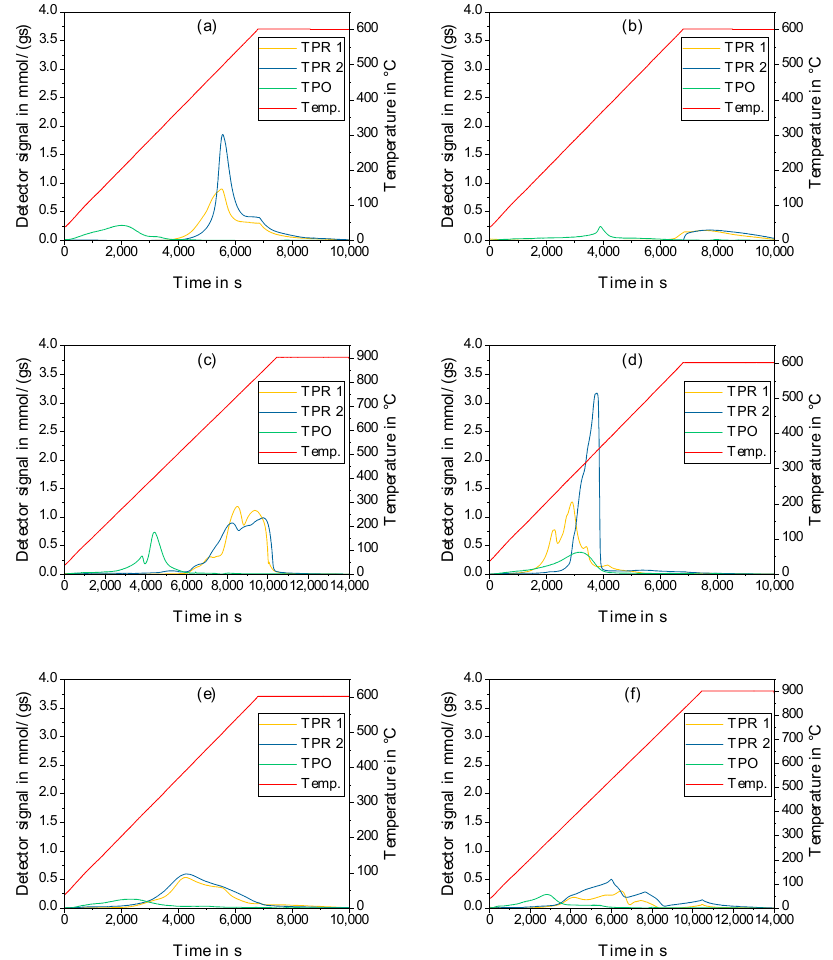
Figure 6. Results of TPROR measurements up to 600 ◦ C ( a , b , d , e ) and 900 ◦ C ( c , f ): ( a ) Molybdenum- silica system with a signal maximum of the second TPR at about 500 ◦ C. ( b ) Tungsten-silica system without significant signals for reduction up to 600 ◦ C. ( c ) Tungsten-silica system with two signal maxima of the second TPR at about 725 ◦ C and about 840 ◦ C. ( d ) Rhenium-silica system with one signal maximum of the second TPR at about 350 ◦ C. ( e ) Iron-silica system with a maximum of the second TPR at about 400 ◦ C, and ( f ) Iron-silica system with a maximum of the second TPR at about 400 ◦ C and another at about 660 ◦